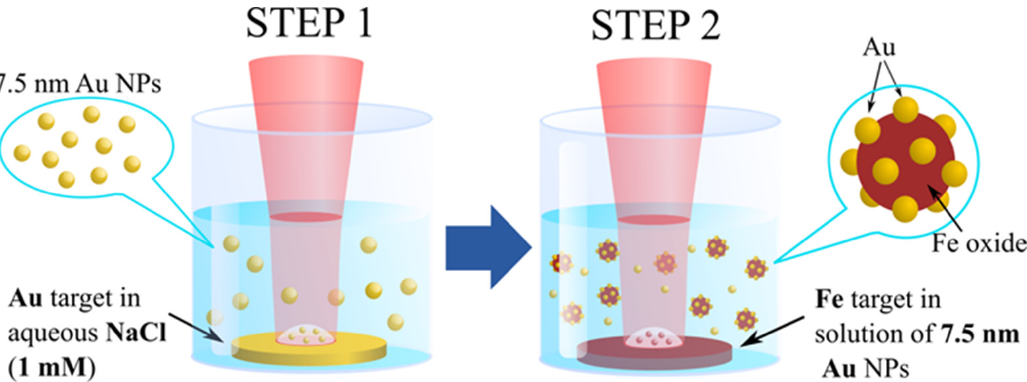
Figure 1. Schematic diagram of two-step PLAL synthesis of core-satellite Au-Fe NPs. Non-reacted Au NPs were eliminated by magnetic separation step. For this a NdFeB magnet was placed for 5 min next to the bottom of the test tube filled with the colloidal solutions of NPs. The magnet attracted magnetic fraction of NPs to the bottom, while nonmagnetic NPs remained dispersed in the solution. Then the solution from the upper part of the test tube was discarded leaving about 20 µL at the bottom and the test tube was refilled with fresh 1 mM aqueous NaCl solution. The NPs remaining in the test tube were re-dispersed by an ultrasonication step. The procedure was repeated two times to ensure